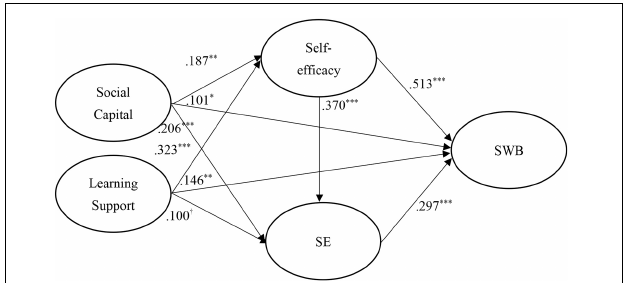
FIGURE 2 | Structural model. † p < 0.1; * p < 0.05; ** p < 0.01; *** p < 0.001.